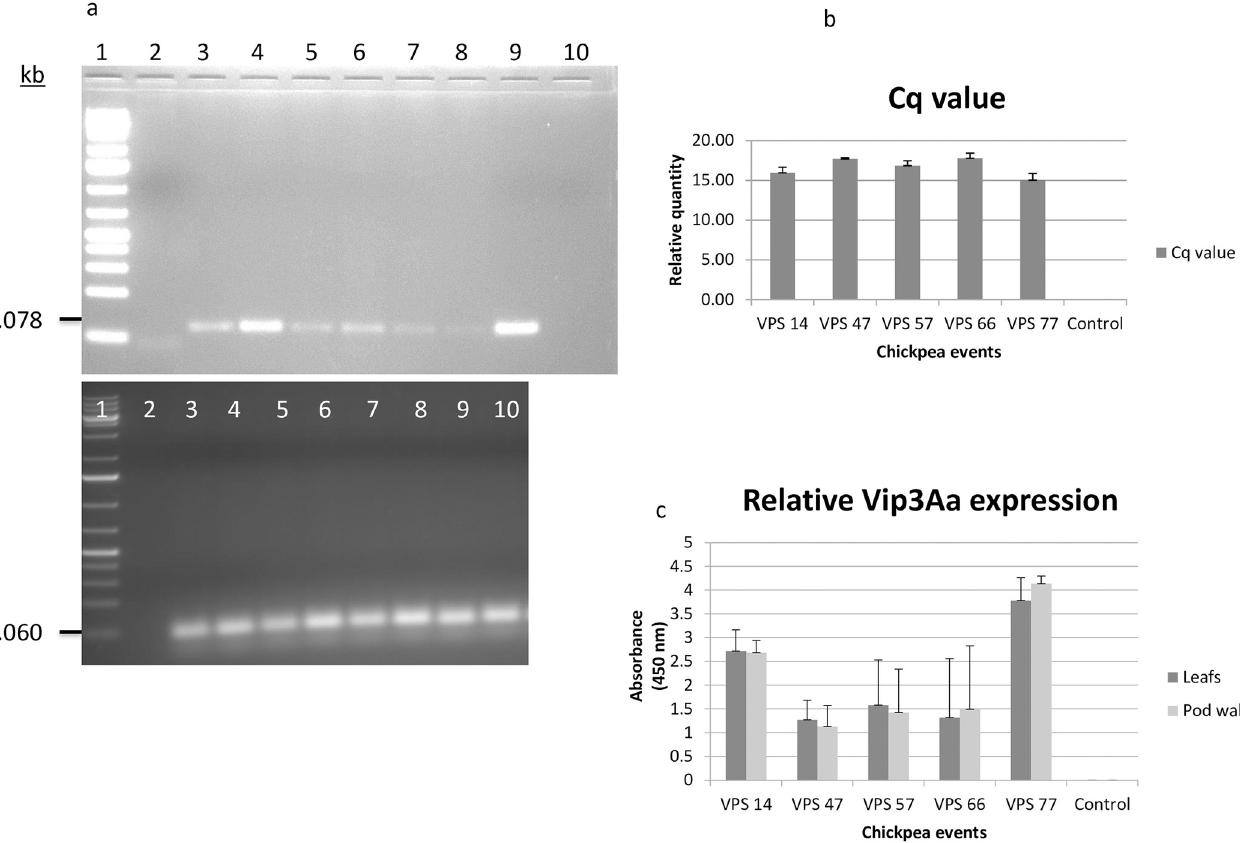
Fig 3. Expression of cm Vip3Aa in transgenic chickpea lines. (a) Panel 1: RT-PCR for cm Vip3Aa transcript (78 bp) in the transgenic chickpea lines [L1: 1 kb plus DNA ladder, L2: No Template Control L3& L4: VPS 14, L5: VPS 47, L6: VPS 57, L7: VPS 66, L8 and L9: VPS 77, L10: Control (DCP 92–3) Panel 2: RT-PCR for internal control, IF4 α transcript (60 bp) in same lane order (b) Comparative expression of cm Vip3Aa in leaves of five transgenic lines and control (c) Absorbance (450 nm) variation depicting cmVIP3Aa expression in leaves and pod walls of five transgenic chickpea lines and control.